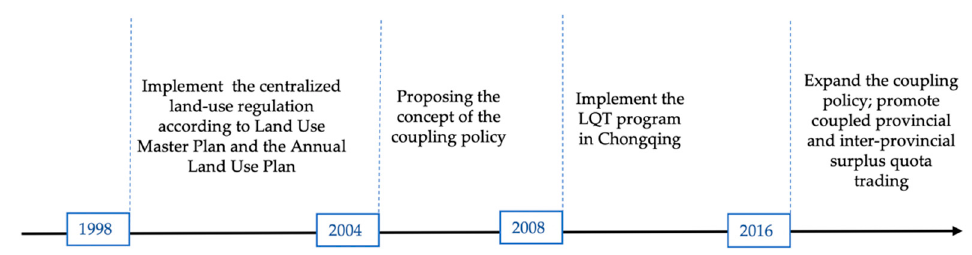
Figure 1. Evolution of the LQT program in China.